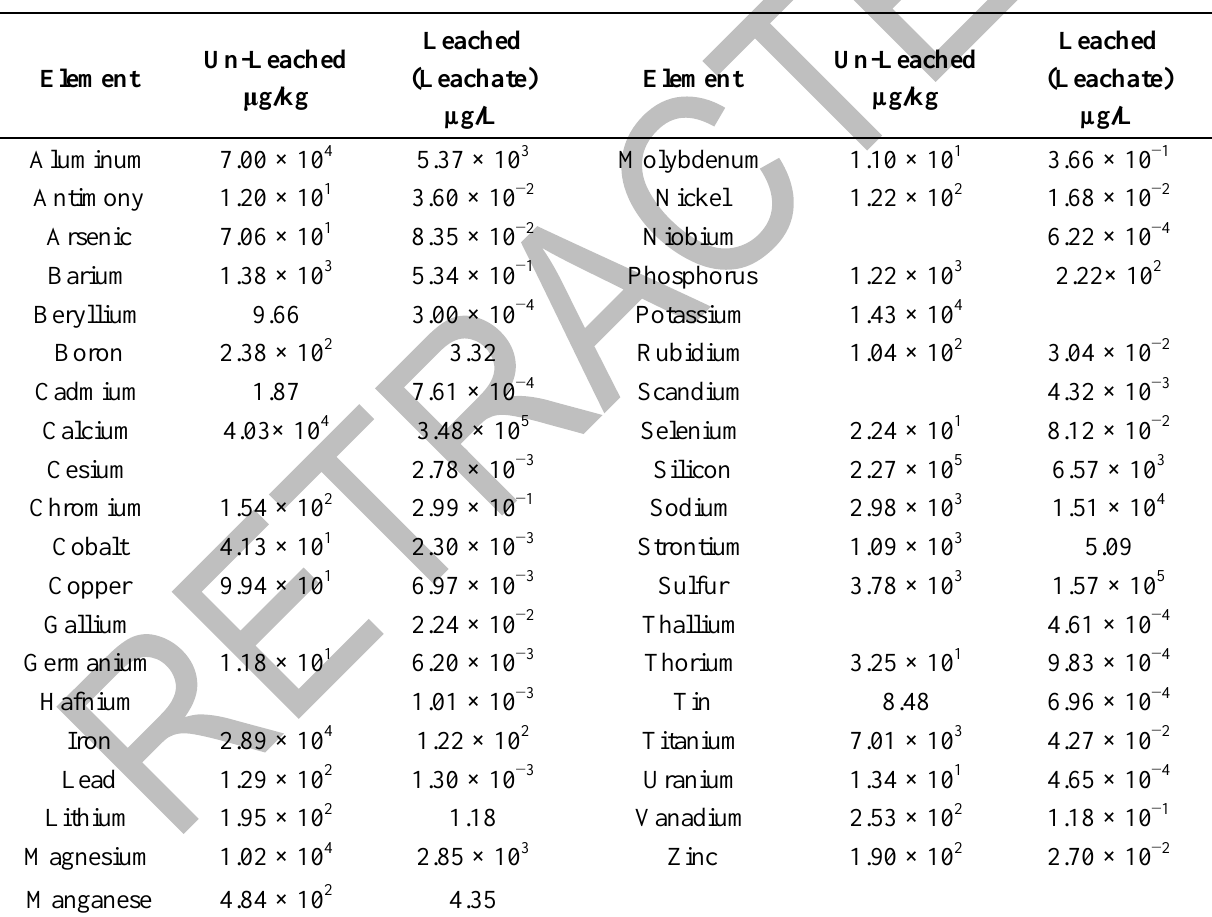
Table 1. Average chemical composition of the 23 un-leached and leached (leachate) European coal fly ash samples from Moreno et al.